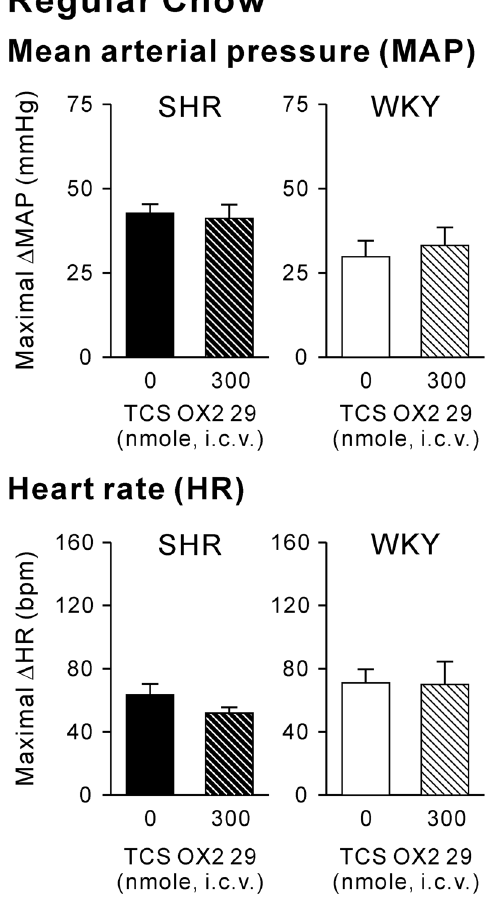
Figure 4. Effects of the orexin 2 receptor (OX2R) antagonist, TCS-OX2-29, on regular-chow consumption- associated cardiovascular responses in spontaneously hypertensive rats (SHR) and Wistar Kyoto rats (WKY). Bar graphs show maximal changes in the mean arterial pressure (maximal Δ MAP) (upper panel) and heart rate (maximal Δ HR) (lower panel) in response to consumption of regular chow in SHR and WKY that received intracerebroventricular (i.c.v.) vehicle ( n = 6) or 300 nmol TCS-OX2-29 ( n = 6). Data are expressed as the mean ±